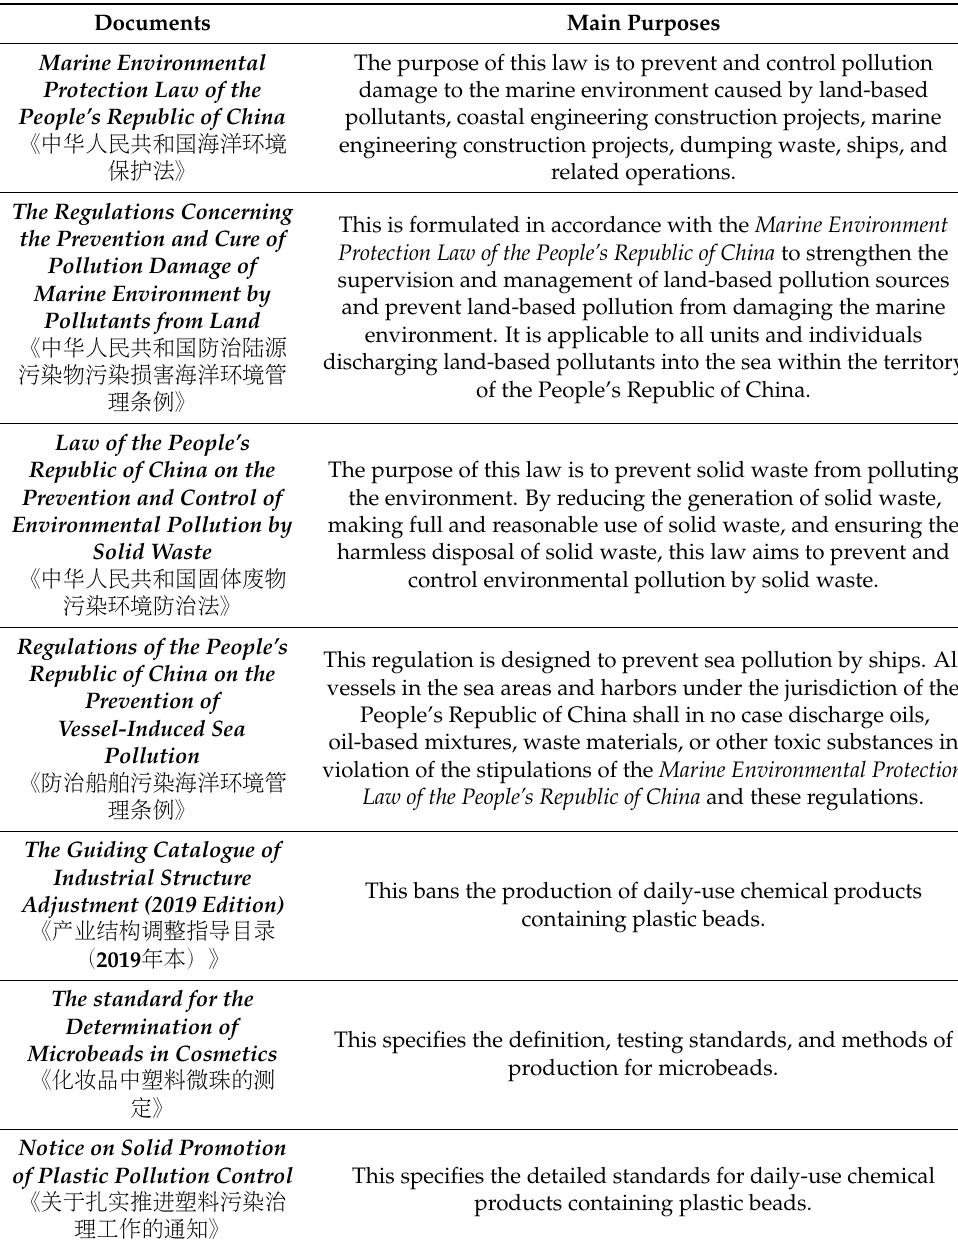
Table 2. Laws and regulations related to marine environmental